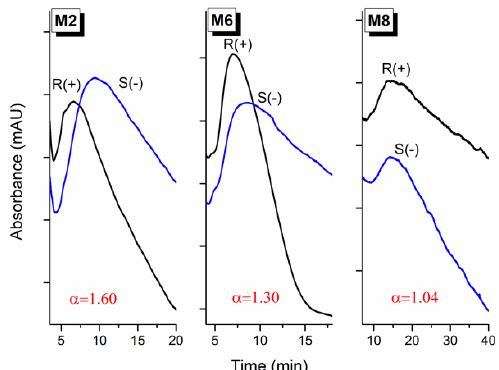
Figure 3. Changes in chromatographic selectivity of metal ion-mediated imprinted (M2), non-covalent imprinted (M6) and non-imprinted (M8) monolithic polymer columns. R(+)—R enantiomer of ATNL, S(−)—S enantiomer of ATNL. For chromatographic conditions see footnote of Table 2.